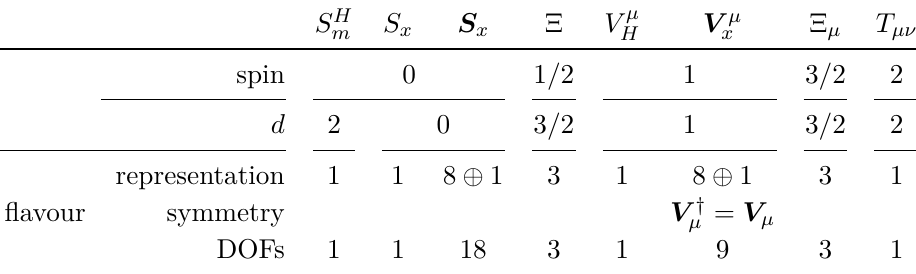
Table 3. Properties of the portal SMEFT currents. The first two rows list spin and mass dimension d , and the remaining rows list the representation and symmetries under flavour transformations as well as the resulting number of